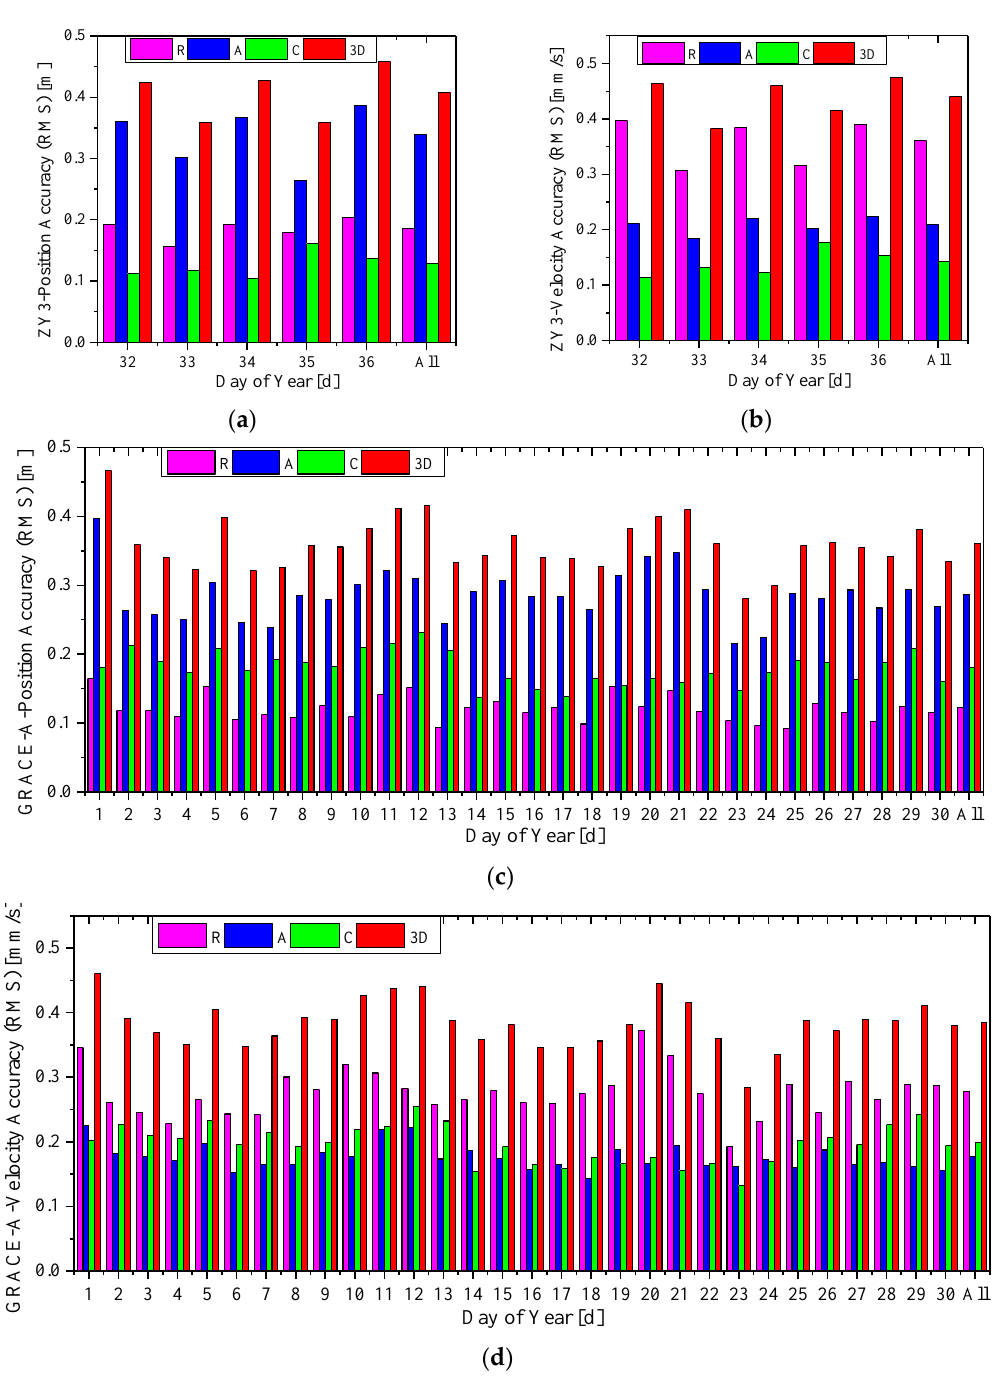
Figure 8. Orbit accuracy of the carrier-phase based solutions for HY2A and MetOp-A. ( a ) Position accuracy of HY2A; ( b ) velocity accuracy of HY2A; ( c ) position accuracy of MetOp-A; and ( d ) velocity accuracy of MetOp-A.